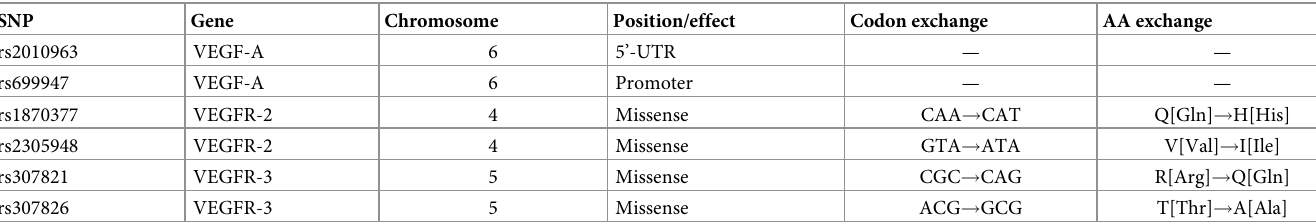
Table 3. Chromosomal location, position in the gene, effect and codon/aminoacid exchange of polymorphism studied group.